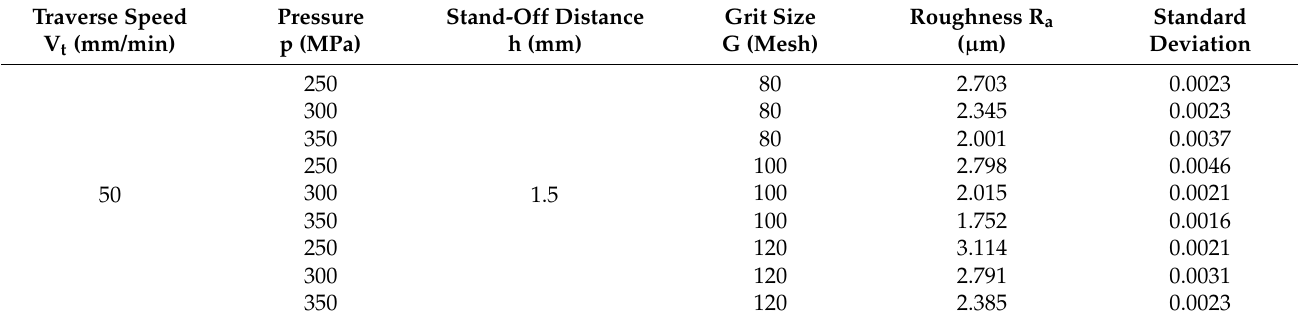
Table 6. Roughness values obtained upon adjusting waterjet pressure and grit size. Traverse Speed V t